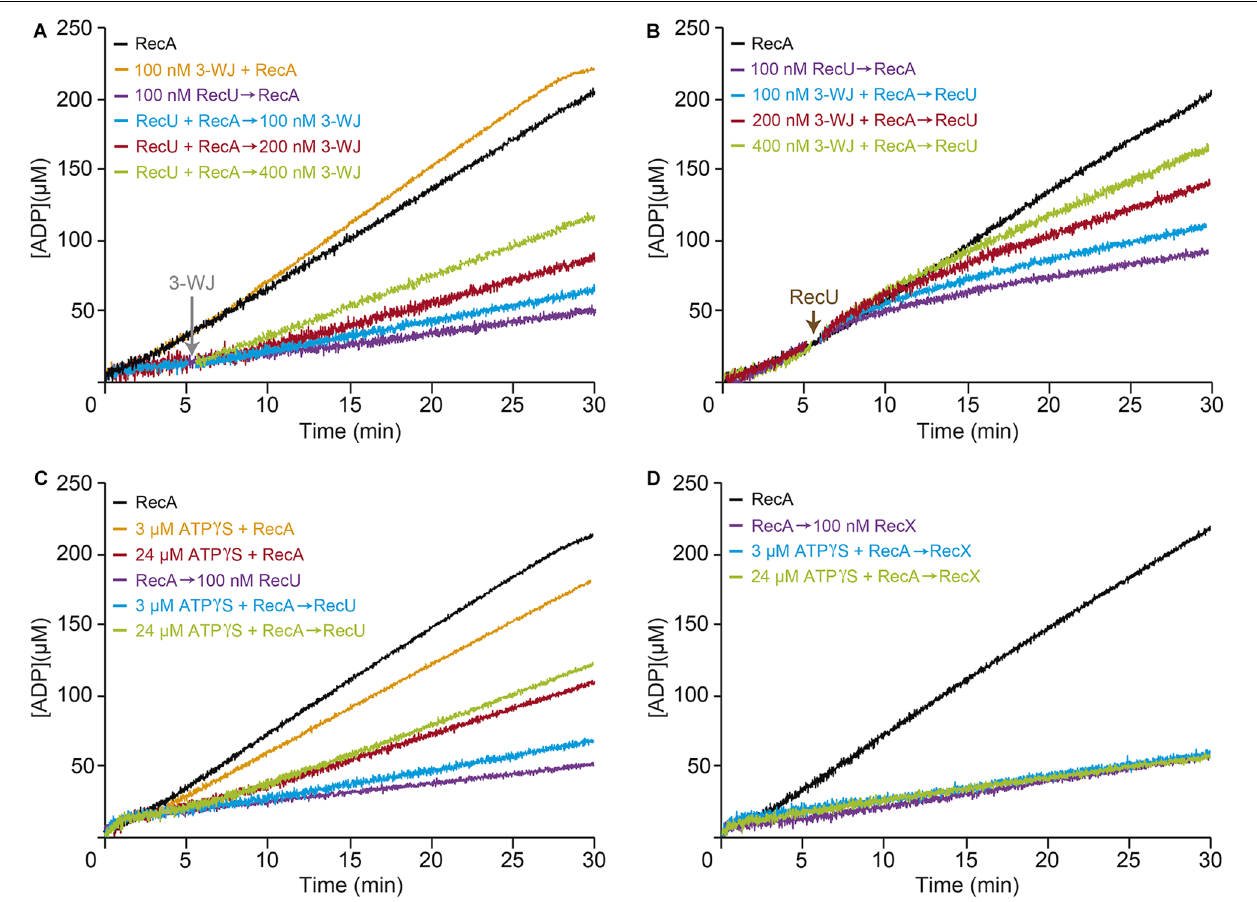
FIGURE 3 | Effect of RecU on RecA nucleation on ssDNA and filament growth in the presence of 3-WJ DNA. Circular 3,199-nt ssDNA (10 µ M in nt) was preincubated with RecA (0.8 µ M) and RecU (100 nM) (A) , or with RecA (0.8 µ M) and increasing concentrations of 3-WJ DNA (100–400 nM in DNA molecules) (B) (5 min, 37 ◦ C) in buffer B containing 5 mM ATP. Increasing concentrations of 3-WJ DNA (A) or a fixed amount of RecU (B) was then added and ATPase activity was measured (30 min, 37 ◦ C). (C,D) The inhibitory effect of RecU on RecA filament extension is different than the one exerted by RecX. Circular ssDNA (10 µ M) was preincubated with a fixed amount of RecA (0.8 µ M) (5 min, 37 ◦ C) in buffer B containing limiting ATP γ S (3 or 24 µ M). A fixed amount of RecU (C) or RecX (D) (100 nM) and 5 mM ATP were added, and ATPase activity was measured. As controls, circular ssDNA (10 µ M) was preincubated with RecA in buffer B lacking or containing limiting ATP γ S (3 or 24 µ M), then ATP was added and ATPase activity was measured. The amount of ATP hydrolyzed was calculated as described. Representative graphics are shown here and quantification of the results is expressed as the mean ± SEM of > 3 independent experiments [see Supplementary Table S1, for parts (A,B) , and Supplementary Table S2, for parts (C,D)